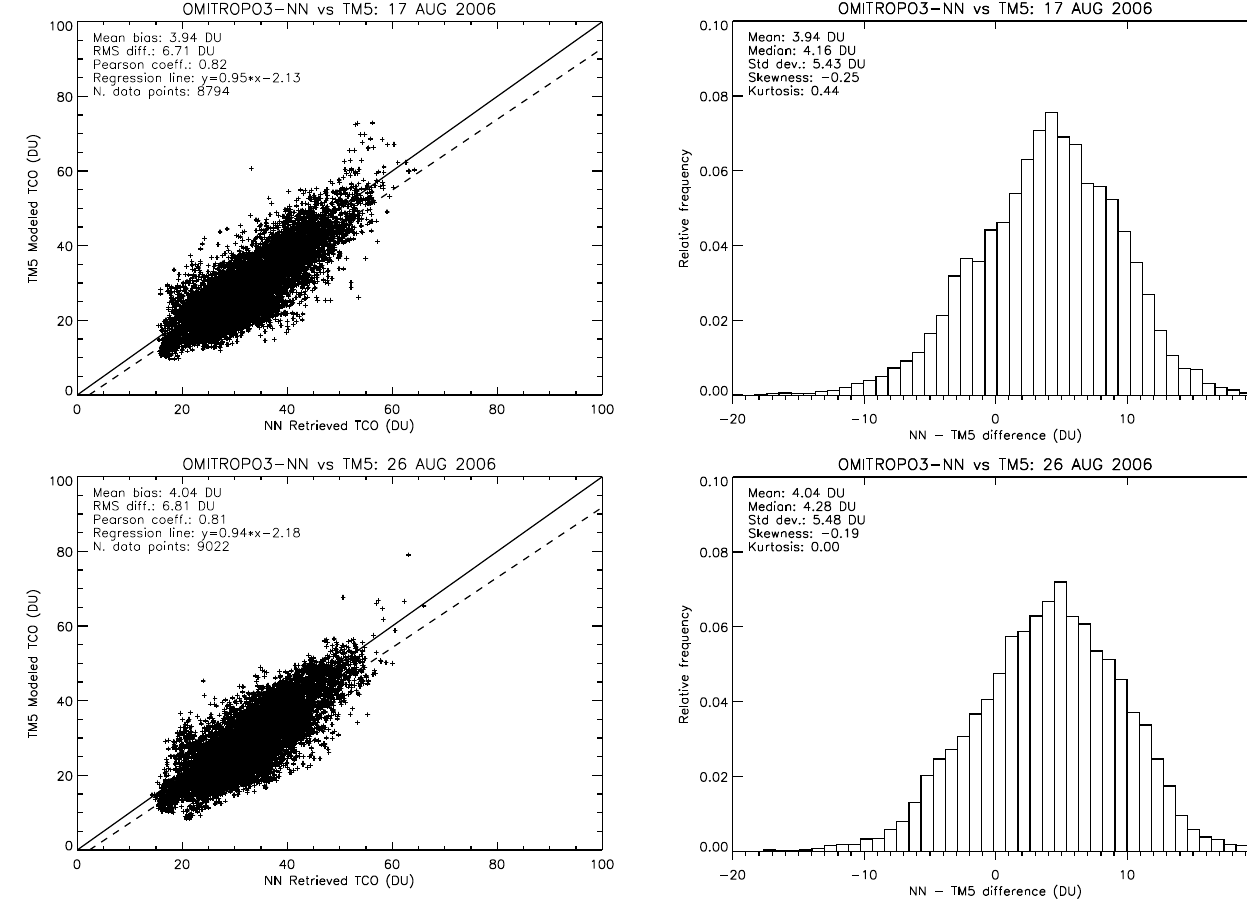
Fig. 14. Histograms of the absolute differences between the OMITROPO3-NN retrievals and the TM5 TCO simulations on 17 (top) and 26 August (bottom) 2006. The OMITROPO3-NN TCO fields are remapped on the TM5